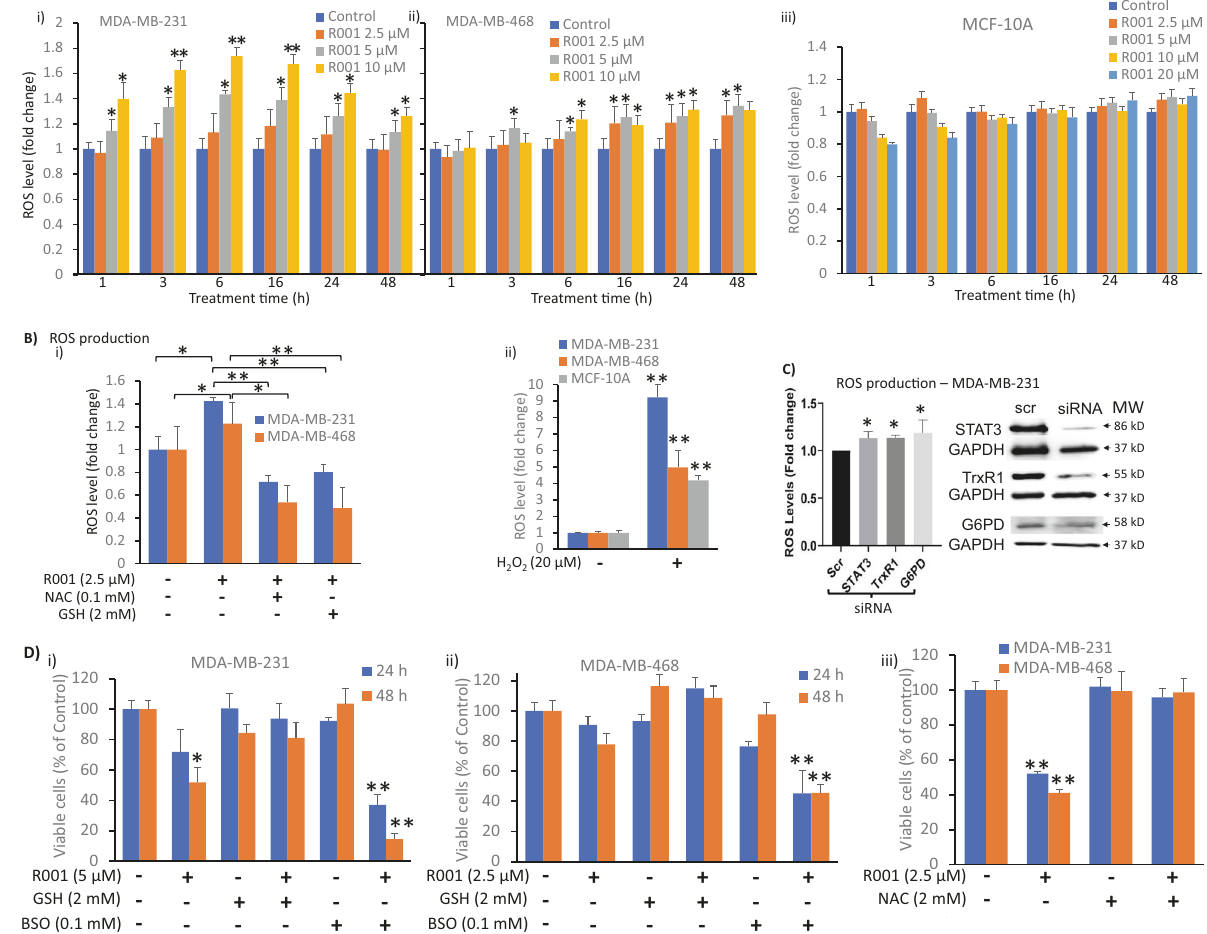
Fig. 4 R001 treatment of tumor cells induces ROS production. A , B MDA-MB-231, MDA-MB-468, or MCF-10A lines were untreated or treated with A increasing concentration of R001 alone for the indicated times or B i 2.5 µM R001, with or without the anti-oxidant N -acetyl cysteine (NAC) or GSH for 24 h, or B ii 20 µM hydrogen peroxide (H 2 O 2 ) for 24 h, and samples were prepared and assayed for reactive oxygen species (ROS) levels, which are plotted against the treatment duration or the conditions of treatment; n = 3; C MDA-MB-231 cells were transfected with scrambled (scr) or pooled speci fi c siRNA targeting STAT3, G6PD, or TrxR1 (right), and samples were prepared and assayed for ROS levels, which are plotted (left); n = 3; D MDA-MB-231 and MDA-MB-468 lines in culture were untreated or treated with 5 µM R001, with or without (i and ii) 2 mM GSH and 0.1 mM buthionine sulfoximine (BSO), or (iii) 2 mM NAC for 24 or 48 h and subjected to CyQuant cell proliferation for viable cell numbers, which are plotted; n = 5. Positions of proteins in gel are shown; control lane (Con, 0, − , scr) represents 0.1% DMSO-treated